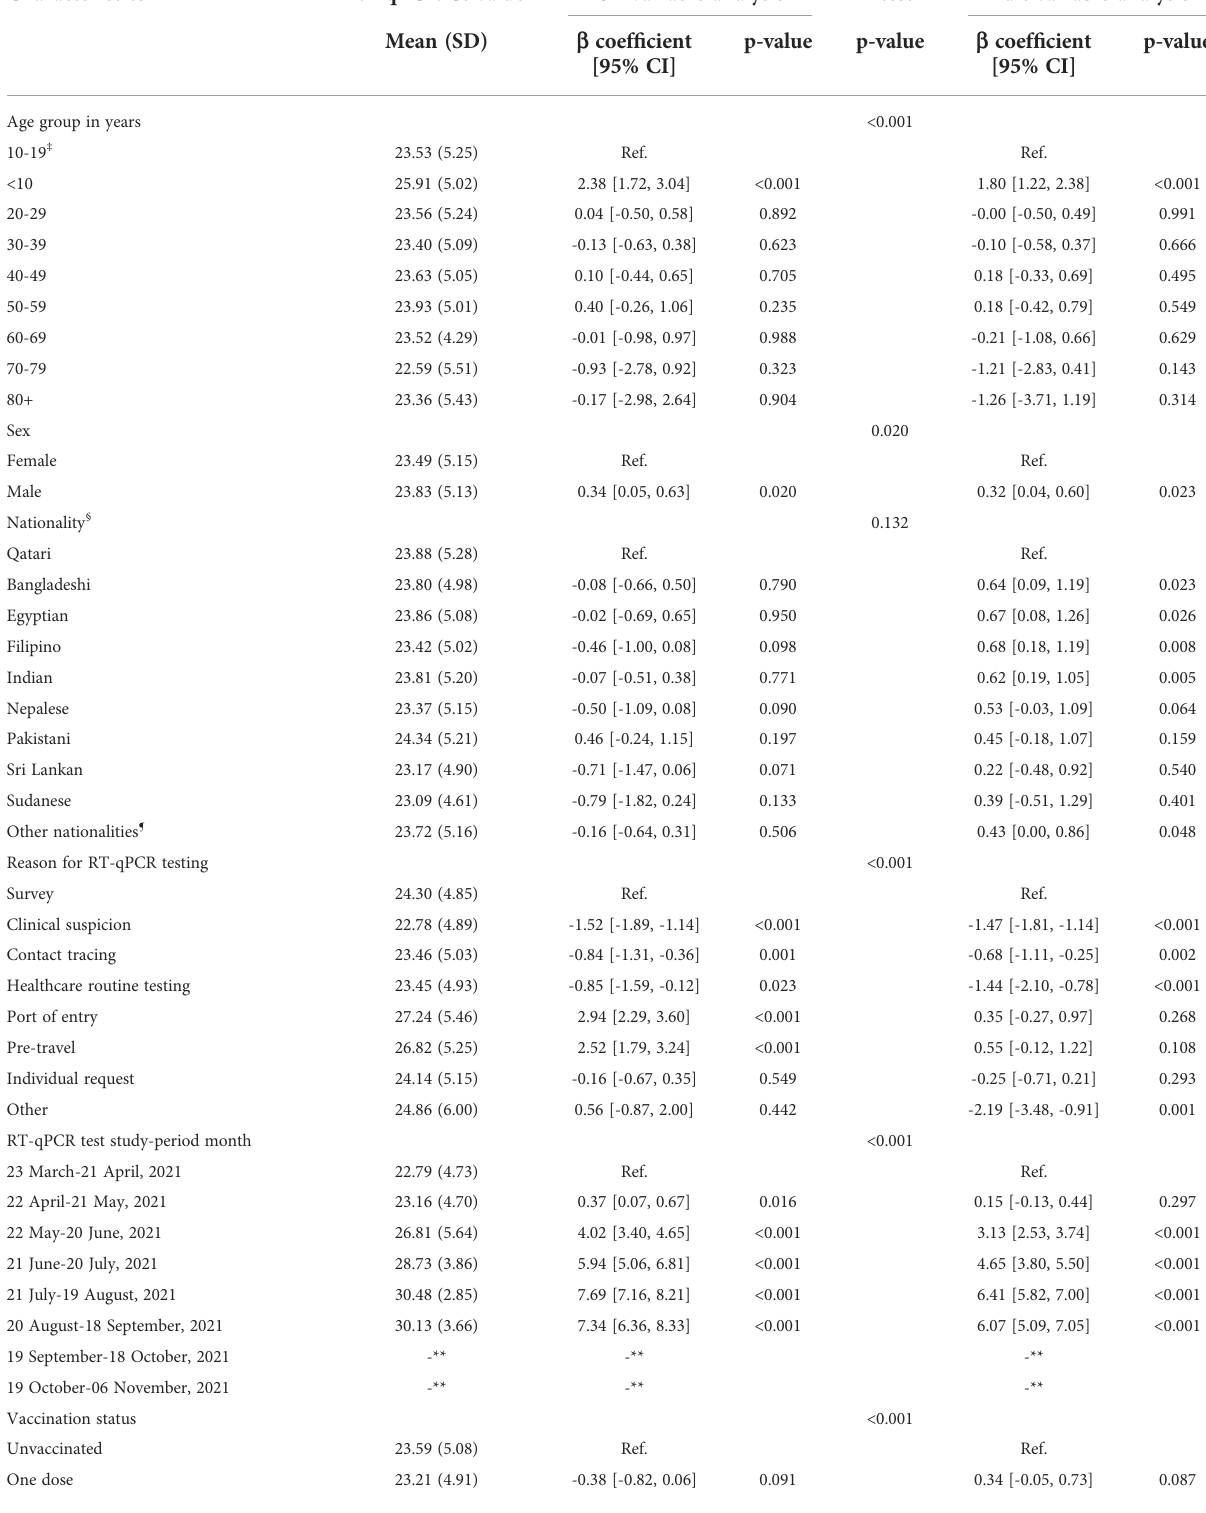
TABLE 4 Associations with RT-qPCR Ct value among 5,576 Beta RT-qPCR-genotyped SARS-CoV-2 infections between March 23 and November 6,